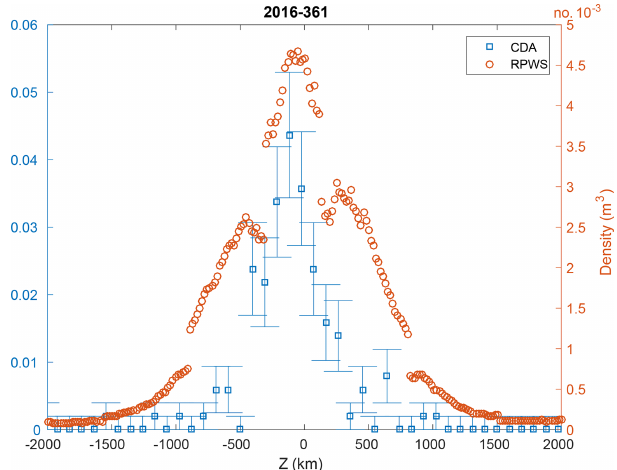
Figure 9. Adapted from Fig. 4 of Ye et al. (2018a). Compari- son of vertical dust density profiles of the Janus–Epimetheus ring measured by RPWS and CDA during the ring plane crossing on DOY 361, 2016. There is 1 order of magnitude of difference be- tween the two results, which is within the uncertainty limit esti- mated for the RPWS measurement (Ye et al., 2014).